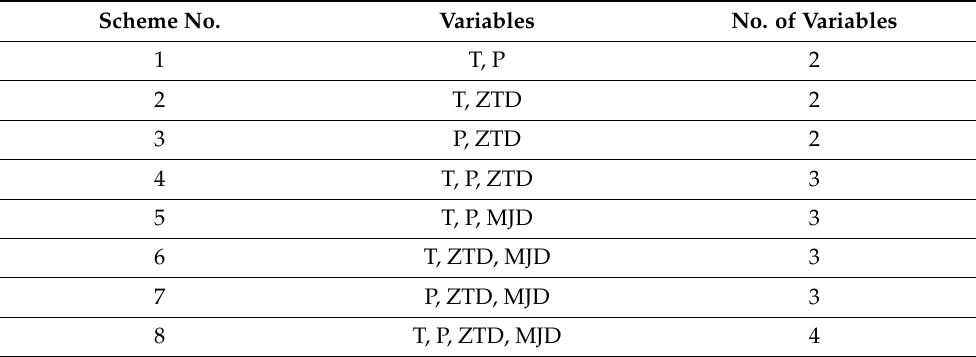
Table 2. Eight experimental schemes for investigating the calibration performances resulting from different combinations of atmospheric variables. (Temperature and pressure are denoted by T and P,